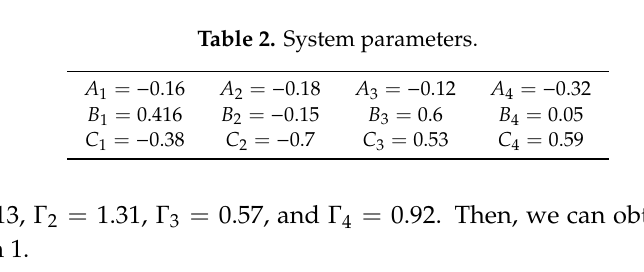
Table 3 for Theorem 1.